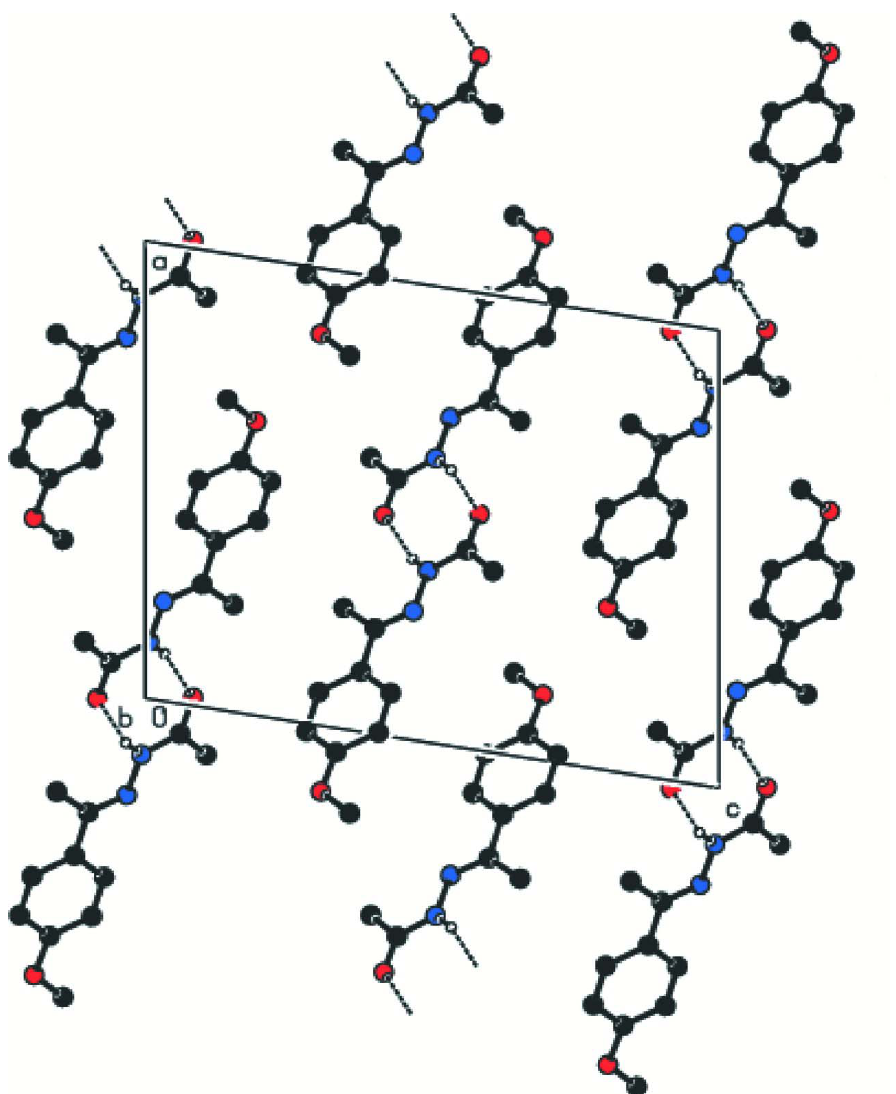
Part of the crystal structure of the title compound showing the formation of a cyclic centrosymmetric dimer. For the sake of clarity, H atoms not involved in hydrogen bonding have been